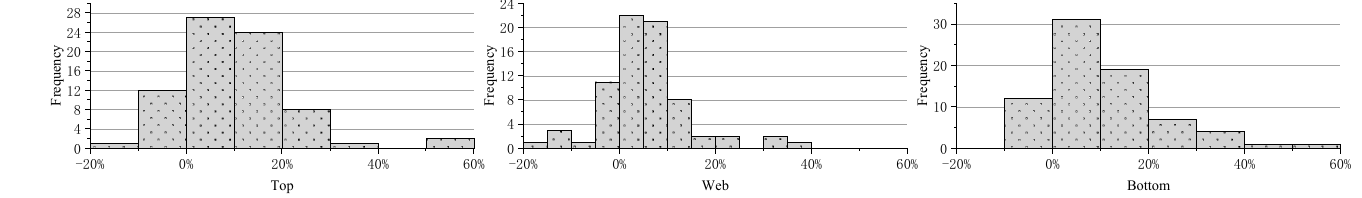
Figure 14. Frequency histogram of K i of each part in the cross-section of bridge B. The average deviation rates of the different parts of the cross-section are close to each other. The average deviation rates of the flange, top slab, web plate, and bottom slab of Bridge A are 7.83%, 7.68%, 6.38%, and 7.70%, respectively. The average deviation rates of the top slab, web plate, and bottom slab of Bridge B are 10.15%, 5.70%, and 10.20%, respectively. The deviation rates of different parts of the bridge A cross-section are within the range of − 16% to 35%, and the deviation rate of the bridge B cross-section is within the range of − 15% to 40%.